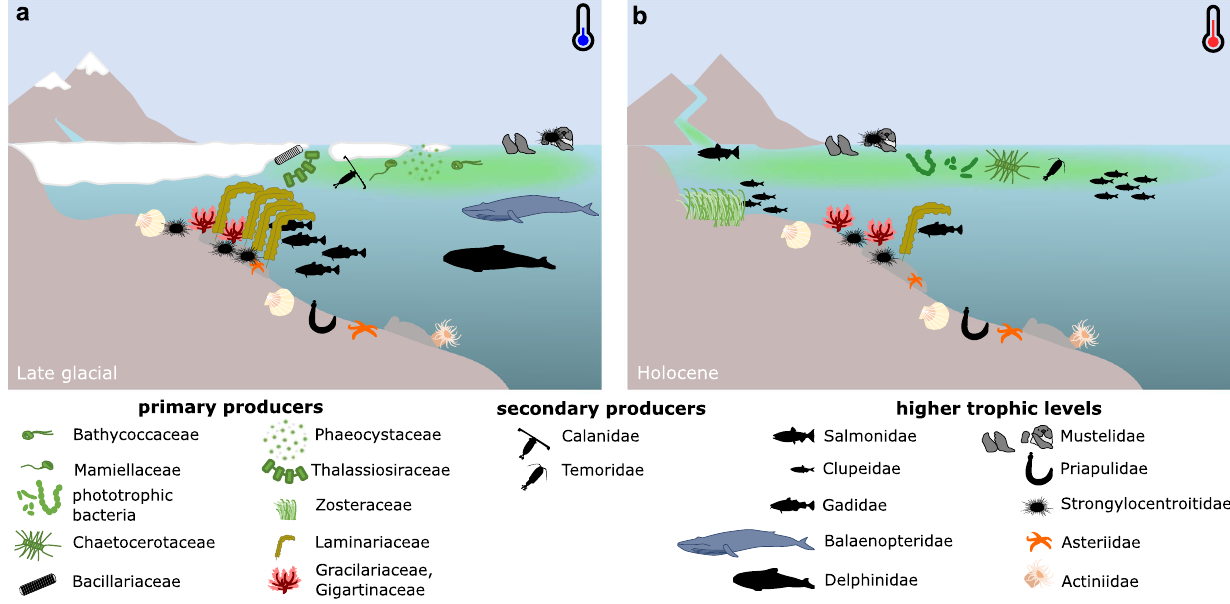
Fig. 5 | Schematic illustrations of ecosystem change after postglacial sea-ice loss. Representatives of functional groups of a the seasonal sea-ice ecosystem, which prevailed for most of the late glacial and b the ice-free ecosystem, which dominated during the